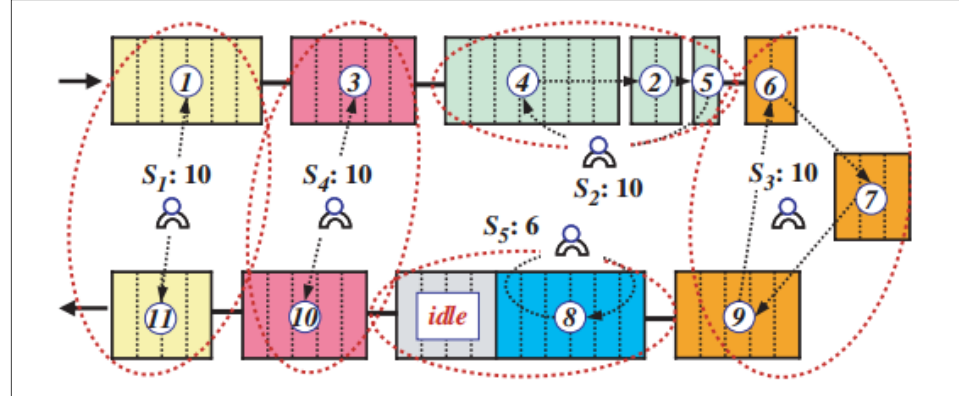
Figure 2. Completed line assignments for the U-shaped assembly line.